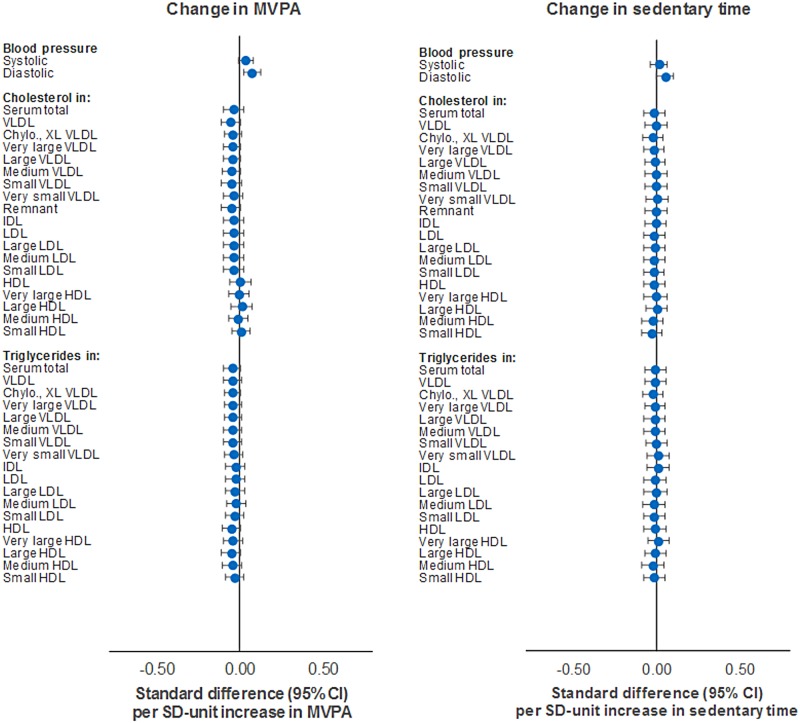
Mutually adjusted associations of change in MVPA and sedentary time with blood pressure, cholesterol, and triglycerides at age 15y in ALSPAC.Metabolic traits are in standardised units. Change in MVPA/sedentary time defined as difference between measures at age 12y and 15y. Models are adjusted for age, sex, ethnicity, maternal education, device wear time and wear month, alternative measure (MVPA or sedentary time), and fat mass index based on change values. ALSPAC, Avon Longitudinal Study of Parents and Children; MVPA, moderate-to-vigorous physical activity.